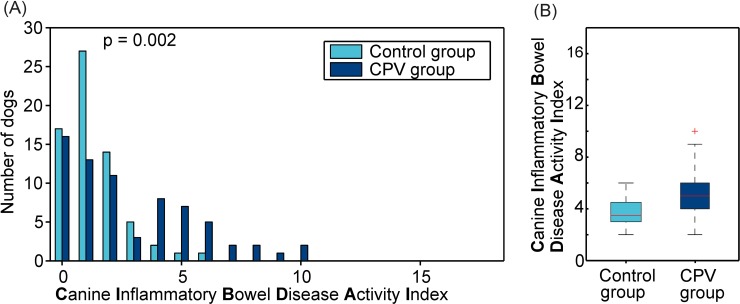
Panel A shows the distribution of the disease activity index CIBDAI (parameters activity, appetite, vomiting, stool consistency, stool frequency, and weight loss) of dogs of the CPV group (n = 71) and dogs of the control group (n = 67) referring to the episodes with the most severe signs of the chronic gastrointestinal disorder. Disease classification: 0–3: clinically insignificant disease, 4–5: mild IBD, 6–8: moderate IBD, > 9: severe IBD Panel B shows the comparison of both groups using a Box-Whisker-Plot.